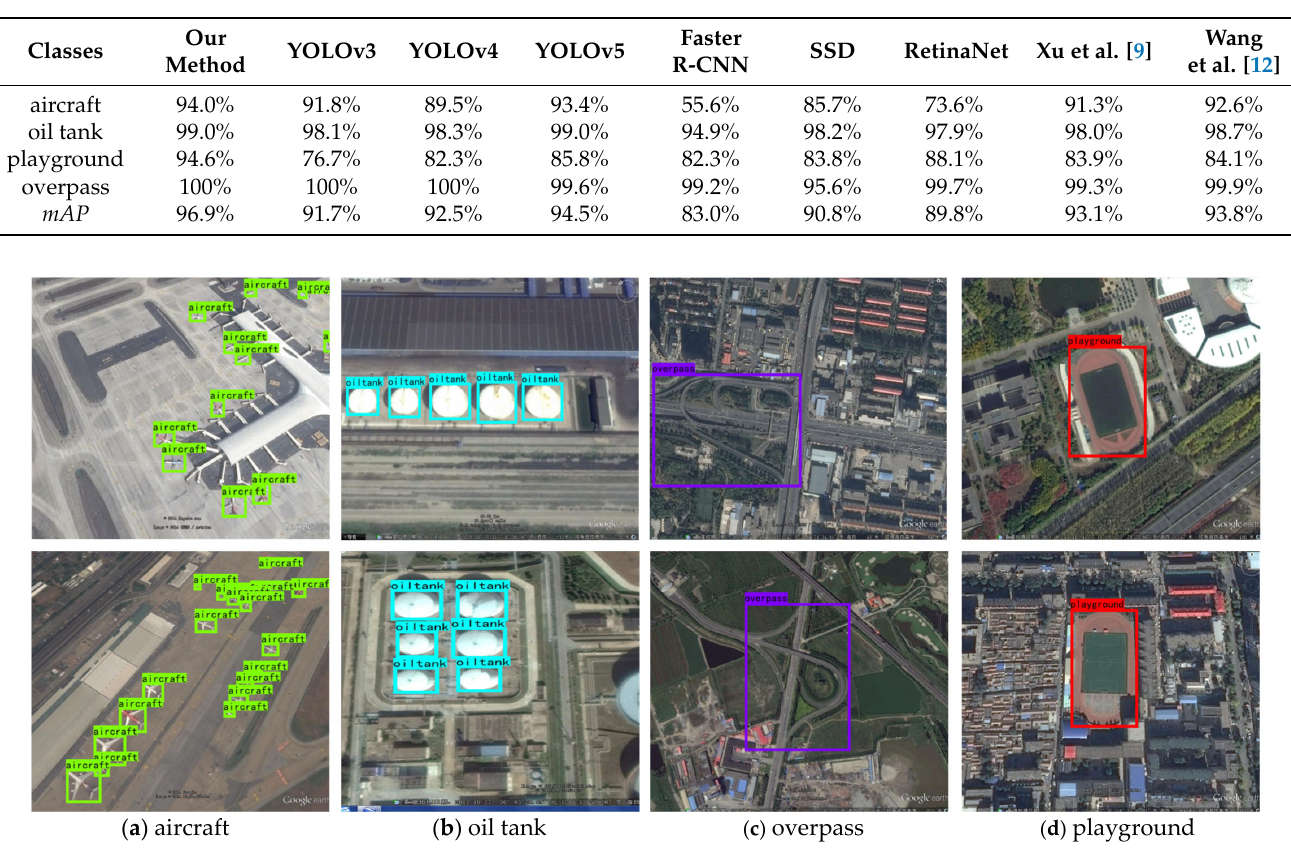
Figure 9. The detection results of our method on the RSOD dataset. Table 2. The experimental results on the ROSD dataset.